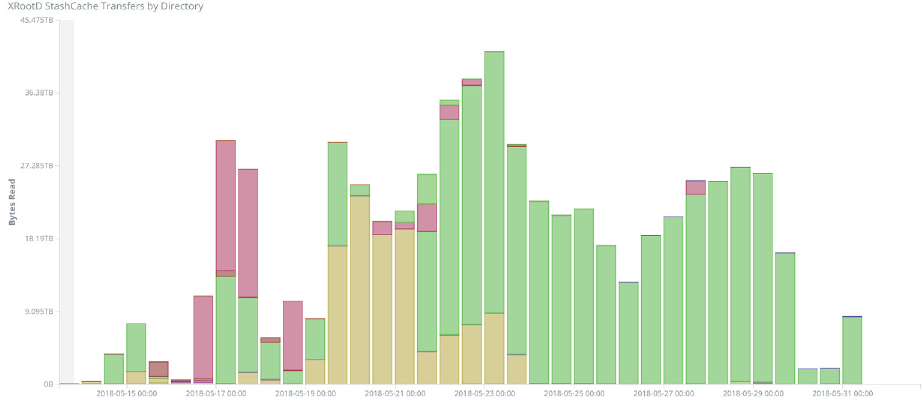
Figure 2. StashCache